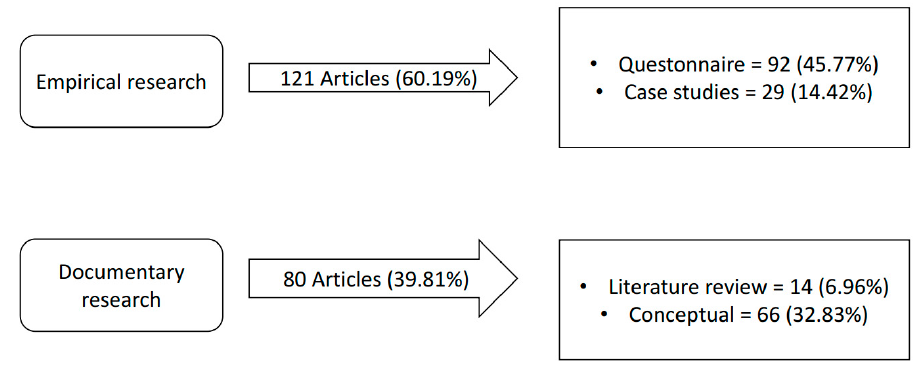
Figure 3. Type of